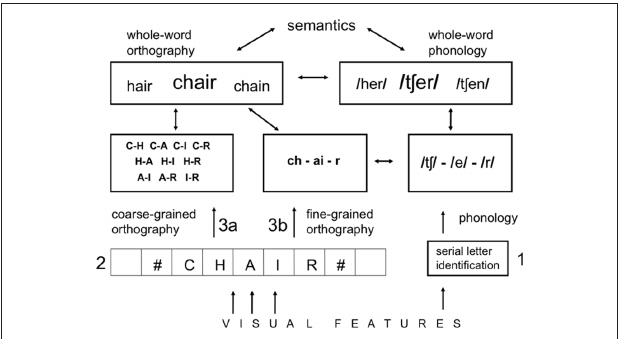
Figure 6 | The major steps involved in learning to read words described within the framework of a multiple-route model of silent reading. (1) Orthographic input is initially processed letter-by-letter, and the corresponding sounds are derived from letters and letter combinations (phonological recoding). (2) Development of parallel independent letter processing in the form of a bank of location-specific letter detectors. (3) Development of two types of location-invariant sublexical representation: (a) coarse-grained representations for fast access to semantics from orthography, and (b) fine-grained representations involving a modification of the process used to translate print-to-sound (grapheme representations) and the development of morpho-orthographic representations